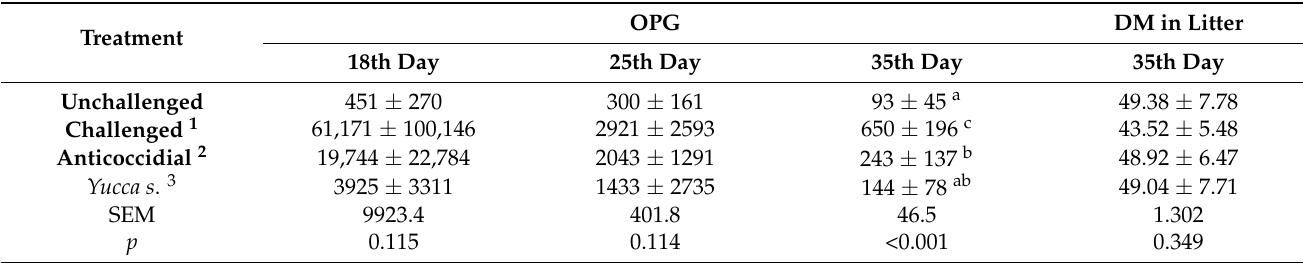
Table 4. Average number of oocysts per gram feces-OPG and dry matter in litter (%) of unchallenged and challenged chickens.